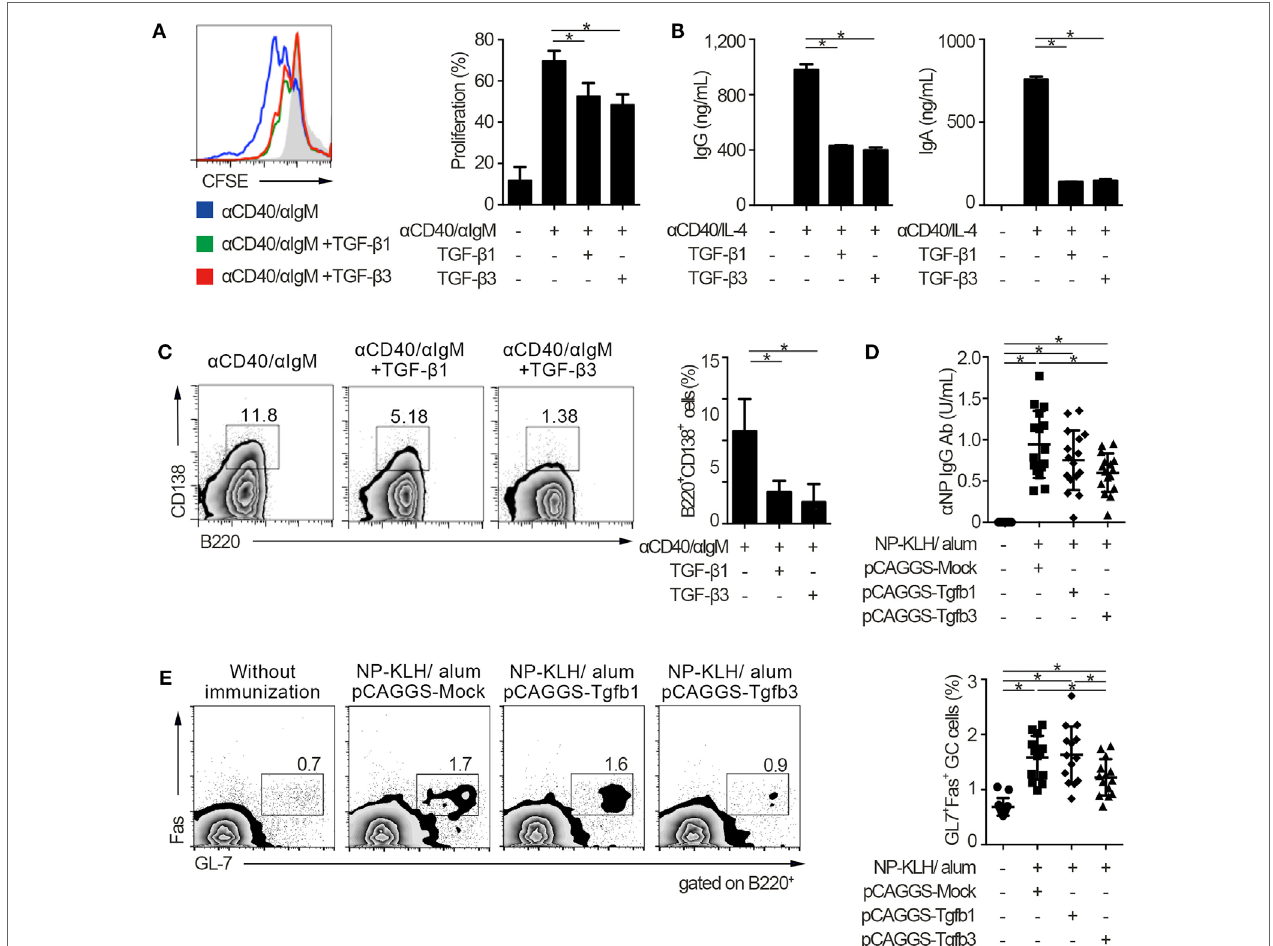
FigUre 1 | TGF- β regulates T cell-dependent B cell activation. (a) Histogram plots of CFSE-labeled B220 + B cells stimulated by 10 µg/ml anti-CD40 and 10 µg/ml anti-IgM either with TGF- β 1 or TGF- β 3 for 3 days ( n = 3). Data are representative histograms with CFSE fluorescence gated on B220 + cells and the percentage of proliferating B220 + CFSE − cells. (B) Total IgG and IgA antibody titers in the supernatants of anti-CD40/IL-4 stimulated B cells with either TGF- β 1 or TGF- β 3 and 50 ng/ml interleukin-10 for 7 days quantified by ELISA ( n = 3). (c) Flow cytometry analyzing the expression of B220 and CD138 in B cells stimulated with anti-CD40/anti-IgM either with or without TGF- β 1 or TGF- β 3 for 3 days (left), and quantification of B220 + CD138 + plasmablasts (right) ( n = 3). Data are representative of three independent experiments in (a–c) . (D) C57BL/6 (B6) mice treated with indicated pCAGGS plasmid vectors were by i.p. injection of 100 µg NP-KLH in alum. Anti-NP-bovine serum albumin antibody titers in the sera ( n = 16) were quantified by ELISA 7 days after the immunization. (e) Flow cytometric (FCM) plots and quantification of GL-7 + Fas + germinal center B cells in B220 + cells from B6 mice administered the indicated pCAGGS vectors and immunized with 100 µg NP-KLH in alum ( n = 13–14). P < 0.05 by one-way analysis of variance followed by Bonferroni’s multiple comparisons test (a–c) , and Holm–Sidak’s multiple comparisons test (D,e) . Error bars,